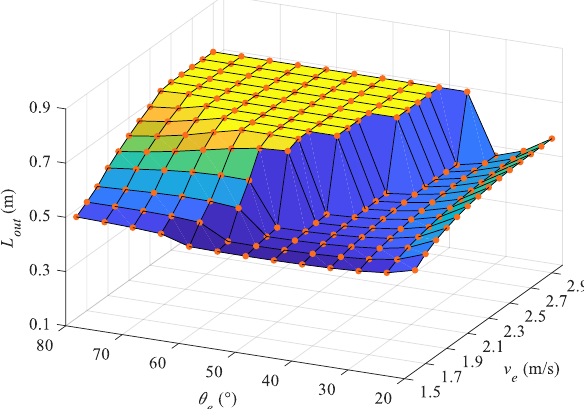
Figure 11. Exiting lengths at different exit velocities and angles.